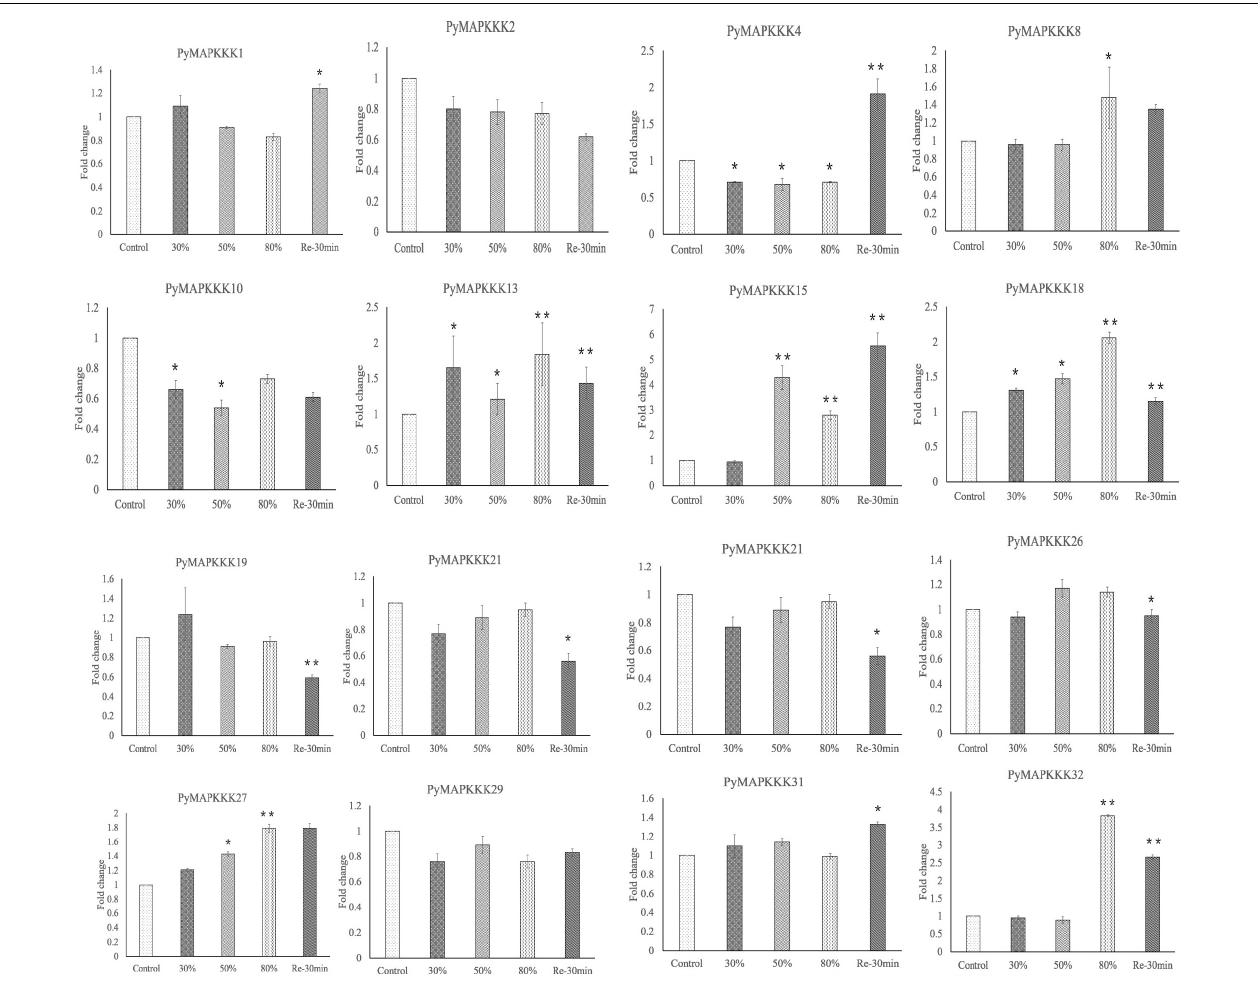
FIGURE 8 | Validation of the expression level of PyMAPKKKs by qRT-PCR analysis. Fold changes in gene expression are shown in terms of log2-fold. Bars show means ± SE of three biological replicates. * and ** means significant difference.